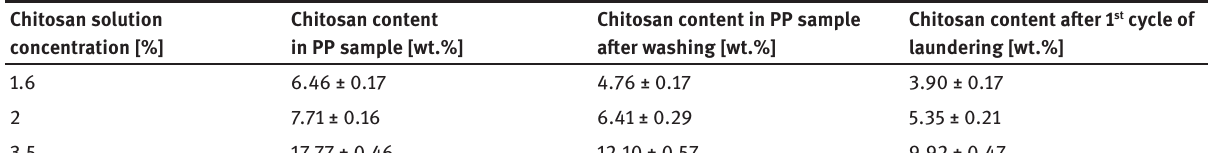
Table 3: The amount of chitosan immobilized to the polypropylene nonwoven after plasma activation in nitrogen atmosphere.